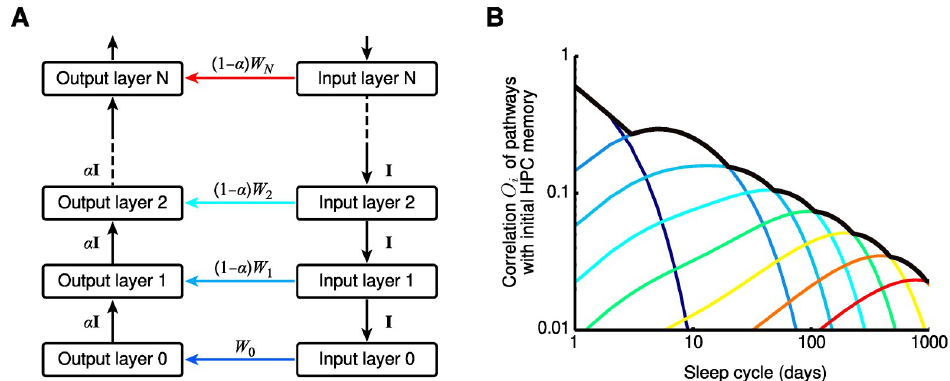
Fig 6. Mathematical analysis of the hierarchical consolidation network. (A) The mathematical analysis is performed for a network consisting of N + 1 input and N + 1 output layers. All output layers (except output layer 0) weight the input from the previous layer with a factor α and the input via the shortcut pathway with a factor 1 − α , to ensure that activity does not rise as increasingly many pathways converge onto the output layers. Input layer i is hence connected to output layer i through a shortcut connection with weight matrix (1 − α ) W (except for the bottom-most layers i = 0, i for which no factor 1 − α is required). All connections between input layers are set to the identity matrix I , and all connections between output layers are set to α I , for notational simplicity in the derivations. The math can be generalized to arbitrary connection matrices, as long as the network is linear. Each connection introduces a synaptic delay of D . The multi-synaptic pathway from input layer i to output layer i via shortcut connection j 6¼ i has a total = 2( i − delay of (2( i − j ) + 1) � D , so the difference in delays between the pathway through shortcut i and shortcut j is D ij j ) � D . (B) The similarity O i of the weight matrix W 0 (in which memory traces are initially stored) and the shortcut connection W as a function of the time elapsed after storage (colored lines), and their maximum (black line). i Simulations shown for D = 2 ms, α = 0.8, η i = 2 − i and STDP time constant τ STDP = 40 ms.